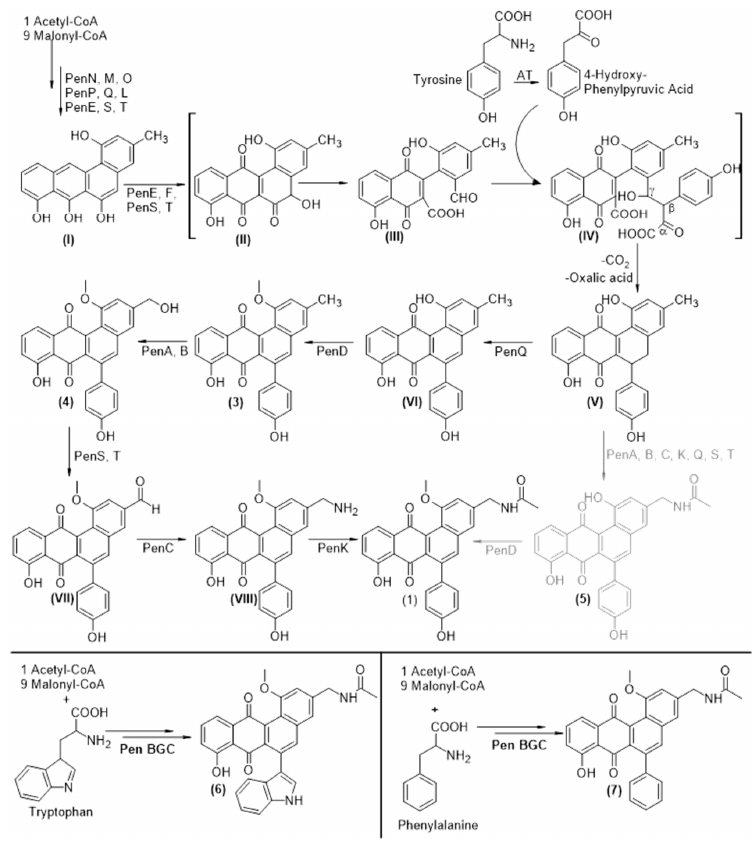
Figure 4. Biosynthetic pathway of pentangumycin; Roman numerals: proposed intermediates; Arabic numerals: intermediates with identified fitting masses after single gene knockouts and overexpression of the regulatory genes; Black pathway: methylation as first biosynthetic step after aromatization; Grey pathway: methylation as last biosynthetic step to complete the formation of pentangumycin ( 1 ) .